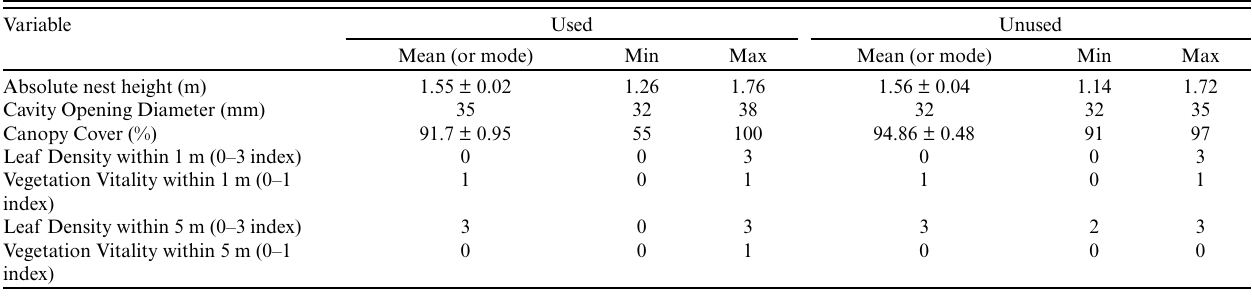
Table 4 . Summary of all microhabitat variables measured for nest boxes (used and unused) by Prothonotary Warblers ( Protonotaria citrea ) in White River National Wildlife Refuge, Arkansas, USA in 2014–2015. We present the mode for cavity opening diameter because we had three discrete opening sizes. Leaf density and vegetation vitality measurements were visually estimated on relative indexes of 0 (low) to 3 (high) and 0 (alive) to 1 (dead), respectively, so we present modes instead of means. All means are presented ± 1 SE. Variable